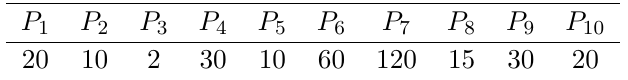
Table 2 . Counting of the number of distinct irreducible varieties generated by each of the P i that, under the action of parity and permutations of the external momenta, generate the set V (2) .